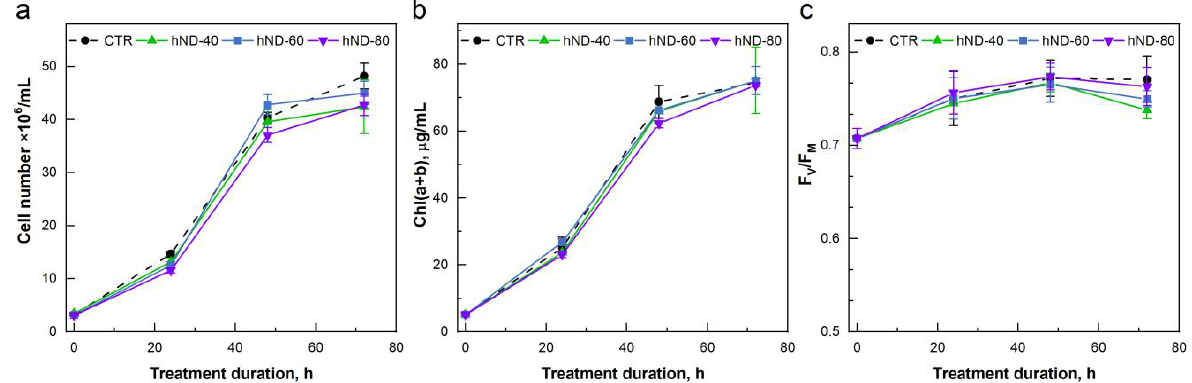
Figure 3. Long-termtoxicitytestofhighhNDconcentrationsin C.reinhardtii cells. Algalculturescontaining 5.1 ± 0.3 µ g Chl/mL were supplemented with 40, 60, or 80 µ g hNDs/mL (hND-40, hND-60 and hND-80) and the changes in cell proliferation ( a ), chlorophyll content ( b ) and F V /F M ( c ) were monitored for 72 h. Average values of 2 independent experiments with 3 biological replicates ( ± SD, n =